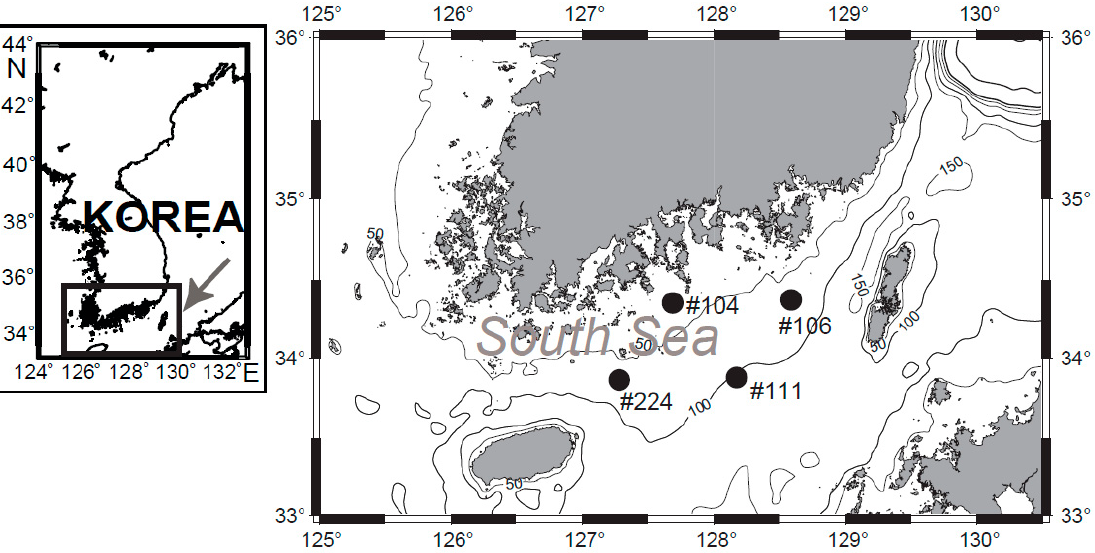
Figure 1. A map showing the location of the sampling areas in the South Sea of Korea. Filled circles indicate the four sampling sites (#104, #106, #111, and #224) at which zooplankton, common squid Todarodes pacificus , and other fish consumers were collected.